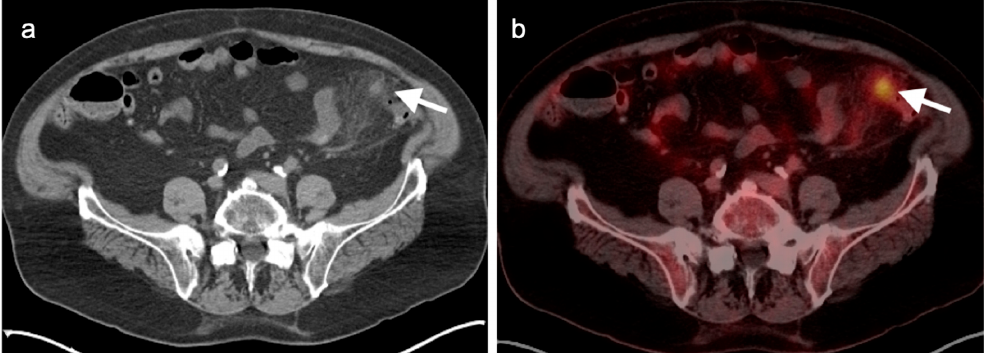
Figure 36. Diverticulitis. Typical features of diverticulitis are shown on axial CT ( a ) and corresponding axial fused FDG PET-CT ( b ) of the lower abdomen. There is an intensely hypermetabolic nodule (white arrow) surrounded by mildly hypermetabolic soft tissue stranding. Differentiation from colon cancer can be difficult in some cases and colonoscopy is typically recommended following treatment for presumptive diverticulitis.